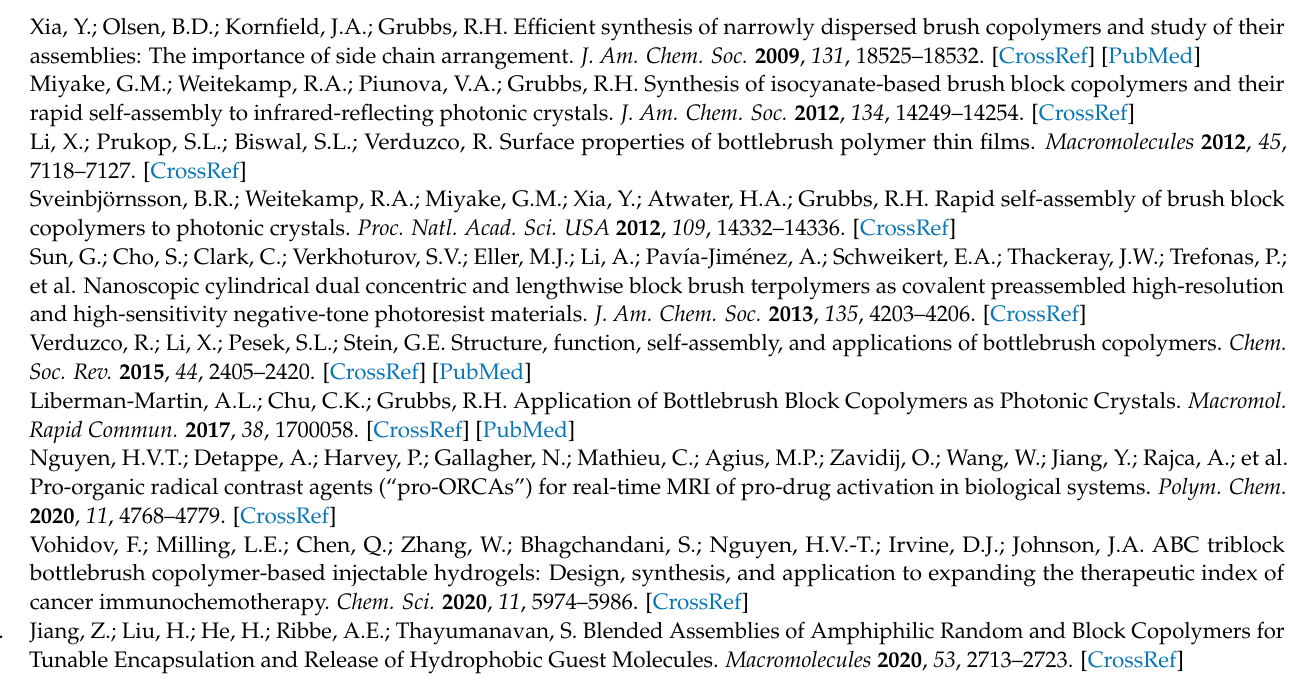
Figure S3: MALDI-TOF MS spectrum of NB-PLLA, Figure S4: MALDI-TOF MS spectrum of NB-PS, Figure S5: 1H NMR spectra of two MMs and of the resulting BBCP, Figure S6: TGA of P3 under nitrogen atmosphere, Figure S7: DSC thermograms of BBCPs recorded at heating rate of 10 ◦ C/ min under nitrogen, Figure S8: AFM height images of P2 spin-cast from chlorobenzene solution onto Si substrate, Figure S9: AFM height images of P4 spin-cast from chlorobenzene solution onto